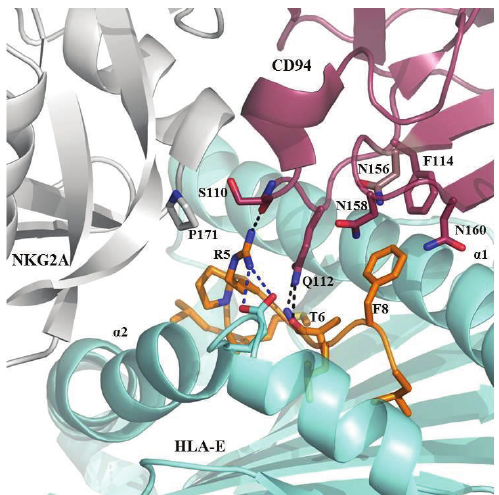
Figure 1: C-terminal peptide residues mediate contact between the HLA-E VMAPRTLFL complex and the CD94/NKG2A receptor. This structure represents the interactions between the CD94/NKG2A receptor and the HLA-E VMAPRTLFL complex (PDB: 3CDG) [4]. The CD94 subunit (raspberry) dominates the recognition of the peptide (orange sticks) with several contacts including hydrogen bonds of Ser110 to the peptide’s p5-Arg and Gln112 to p6-Thr. The peptide’s p8-Phe is surrounded by a polar pocket created by Asn156, Asn158, and Asn160 and van der Waals contacts with Phe114. p5-Arg also builds a salt bridge to Glu152 of the HLA-E heavy chain (pale teal) that may prevent more charged interactions with CD94/NKG2A. Residue Pro171 of NKG2A (pale grey) interacts with p5-Arg by van der Waals interactions. Hydrogen bonds are represented as black dashed lines, and salt bridges are given in